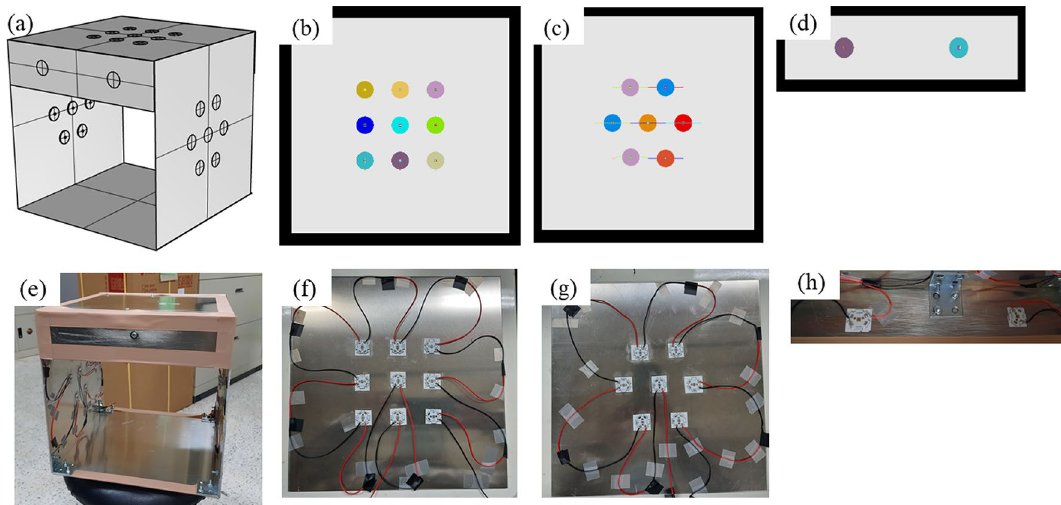
Figure 2. Arrangement of UVC LED for ( a ) whole box, ( b ) top plate, ( c ) side plate, ( d ) sidebar in simulation; arrangement of UVC LED for ( e ) whole box, ( f ) top plate, ( g ) side plate, ( h ) sidebar in experiment.